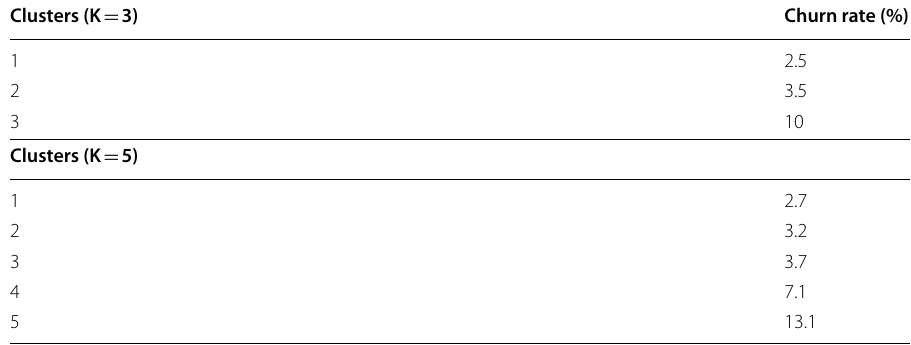
Table 1 Profiles defined with K-means clustering in health insurance firm Clusters (K =